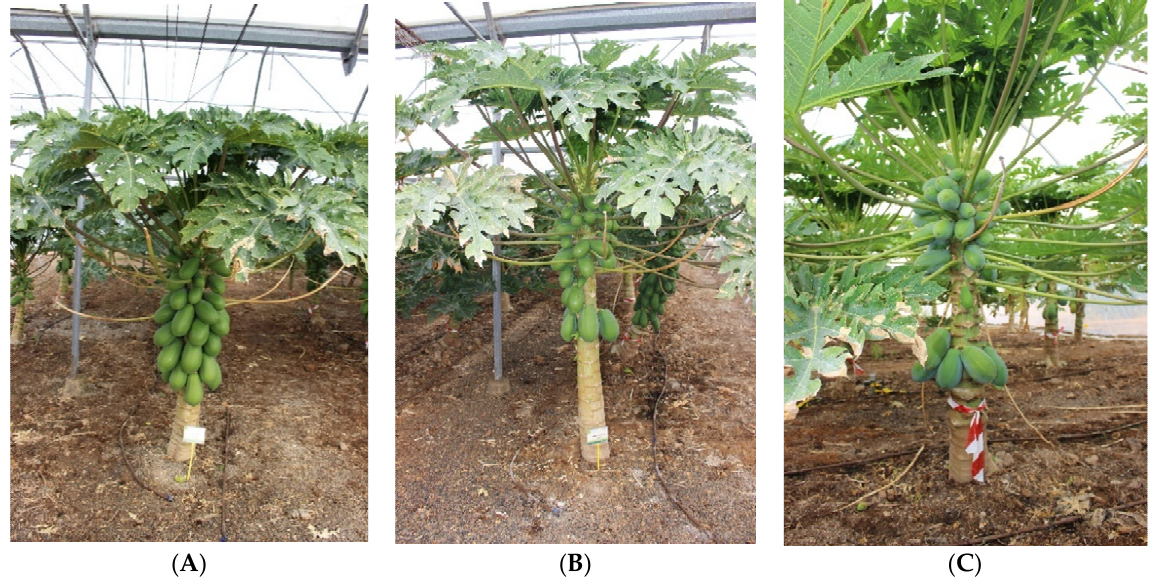
Figure 4. ‘Alicia’ papaya plants propagated by ( A ) seed, ( B ) grafting, and ( C ) in vitro.